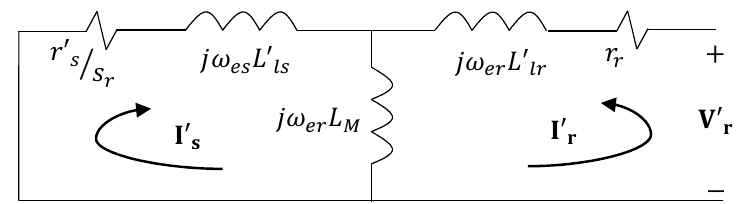
Figure 3. Steady-state equivalent circuit of the generator seen from the rotor.